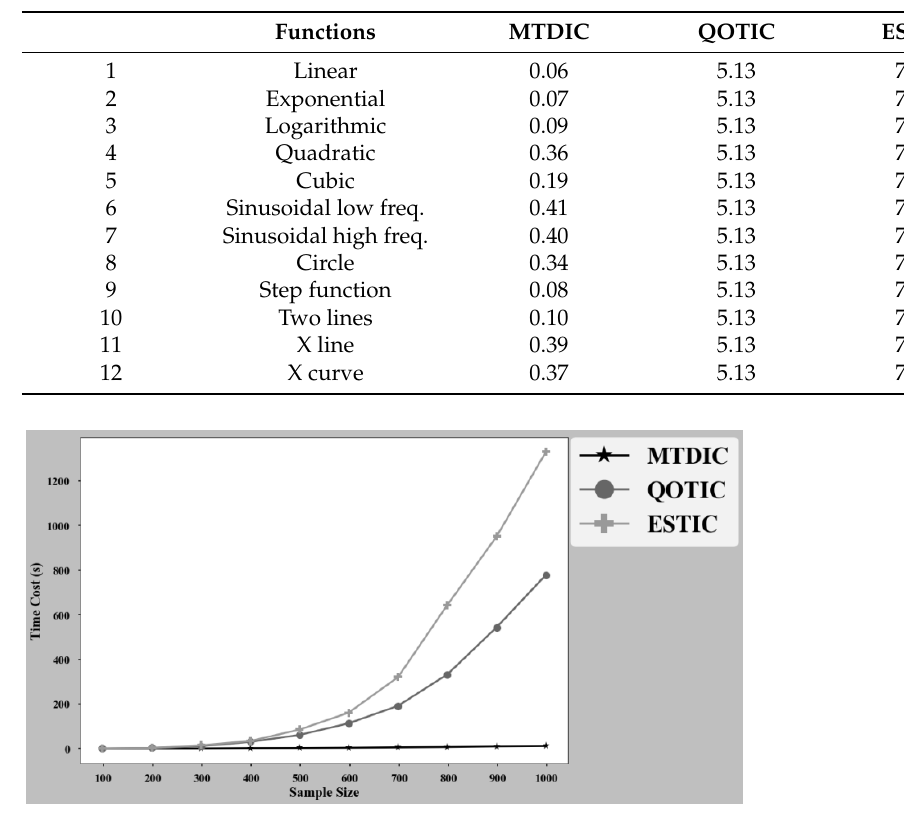
Figure 7. Time cost with different sample size s. Table 4. Time cost of MTDIC, QOTIC, and ESTIC